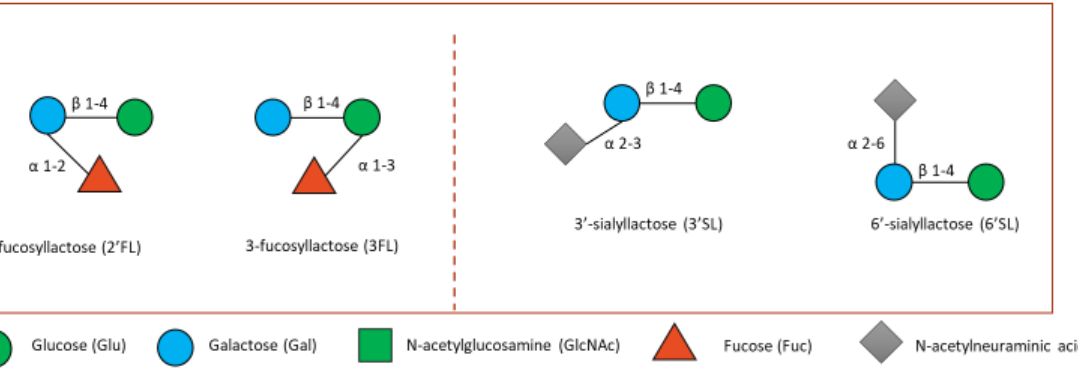
Figure 4. Small fucosylated ( left ) and sialylated HMOs ( right ). Lactose can be fucosylated or